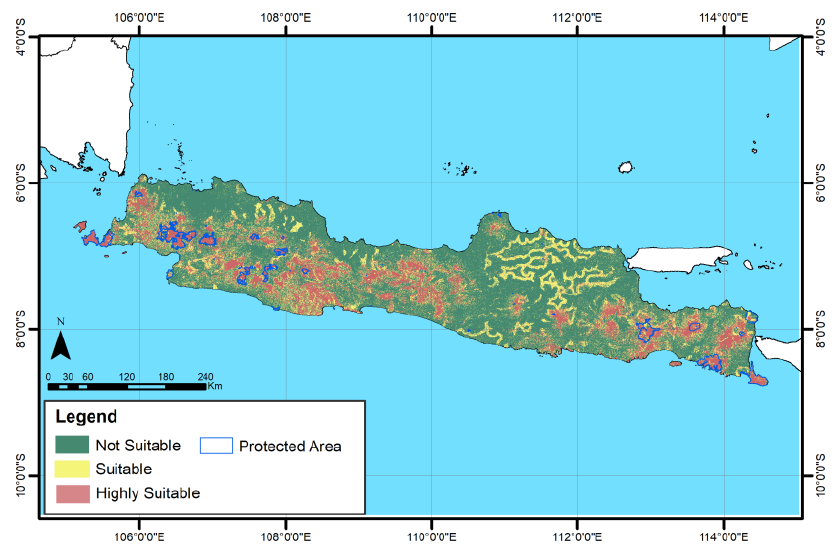
Figure 8. Map of highly suitable habitat for the Javan leopard in conservation areas in 2000.